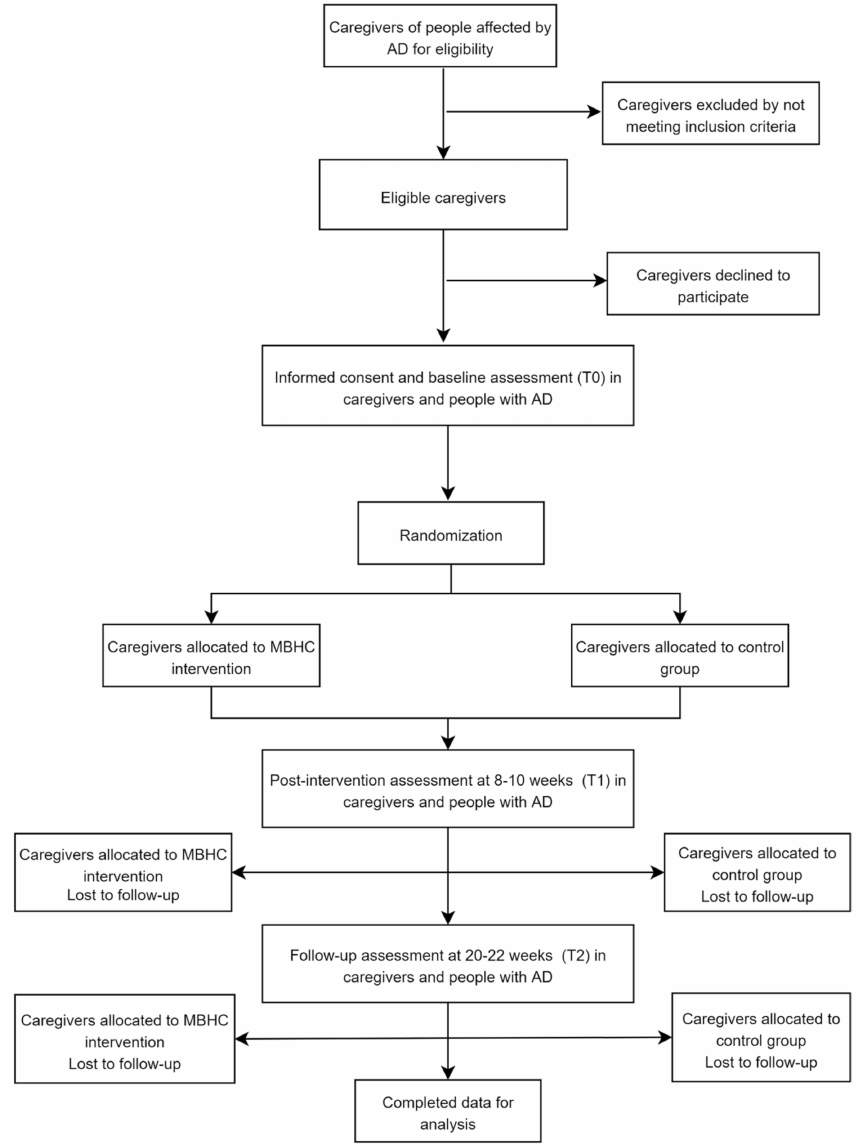
Figure 1. Flowchart of participants in the ATENEA project. Abbreviations: AD, Alzheimer’s disease; MBHC, Mindfulness-Based Health